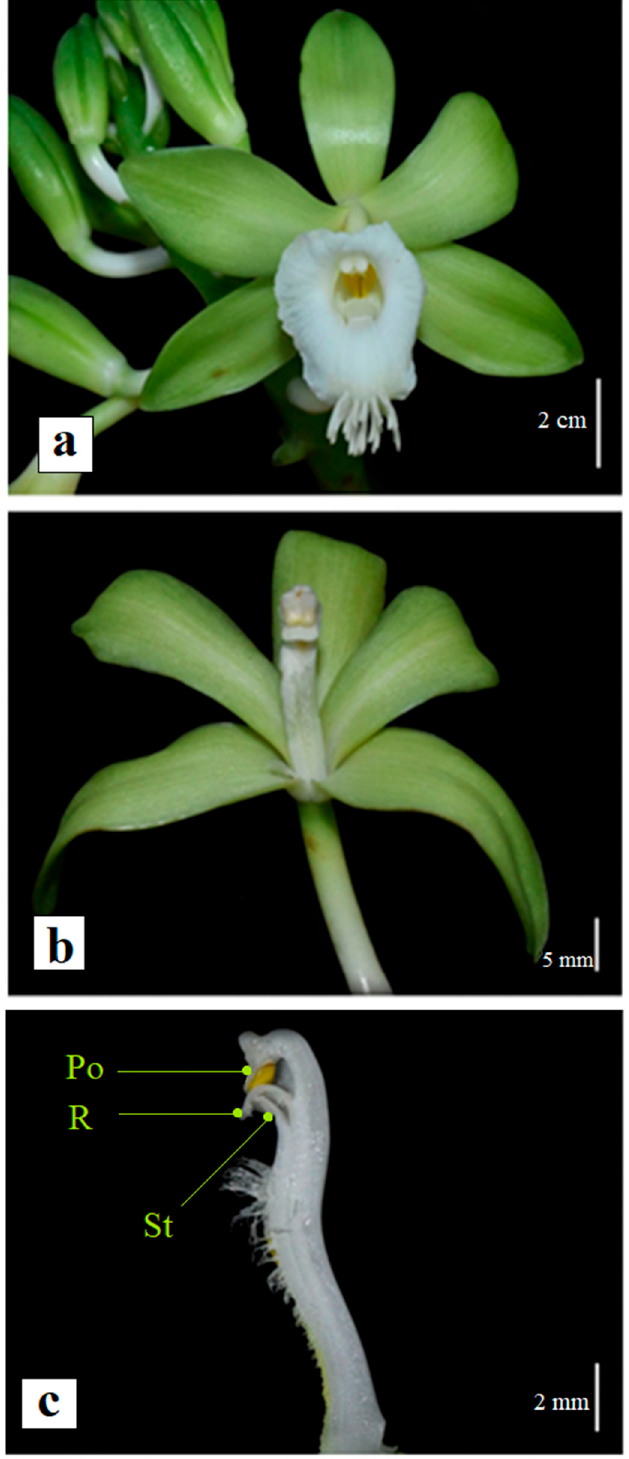
Figure 3. ( a ) Flower and floral buds of Vanilla siamensis . ( b ) Flower after labellum removal, with the column in evidence. ( c ) Longitudinal section of the column showing the anther bearing the pollen mass (Po), rostellum membrane (R), and stigma (St). The figure was adapted from Chaipanich et al. [51].